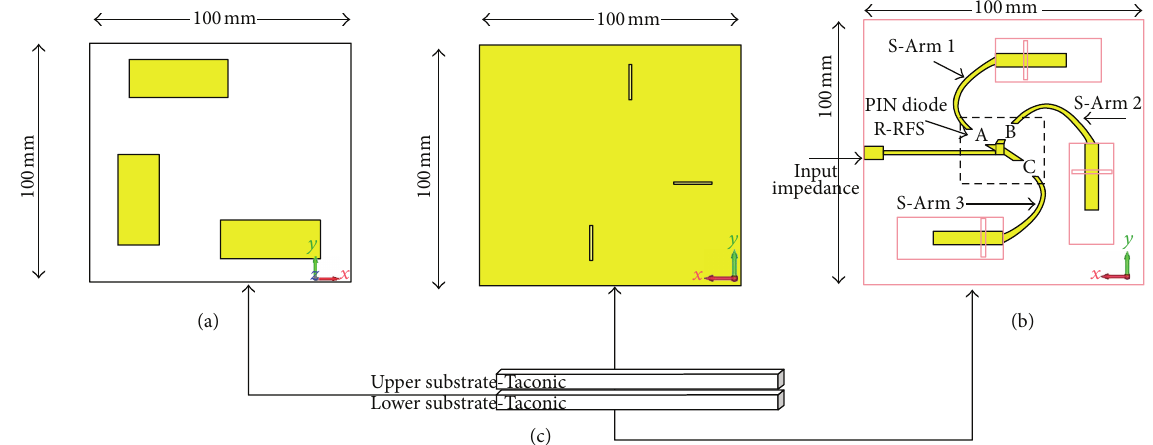
Figure2:Structureofthesimulatedantenna.(a)Radiatingelementsurface.(b)Rectangularslotaperturecoupled.(c)Spiralfeedlinearrange- ment.